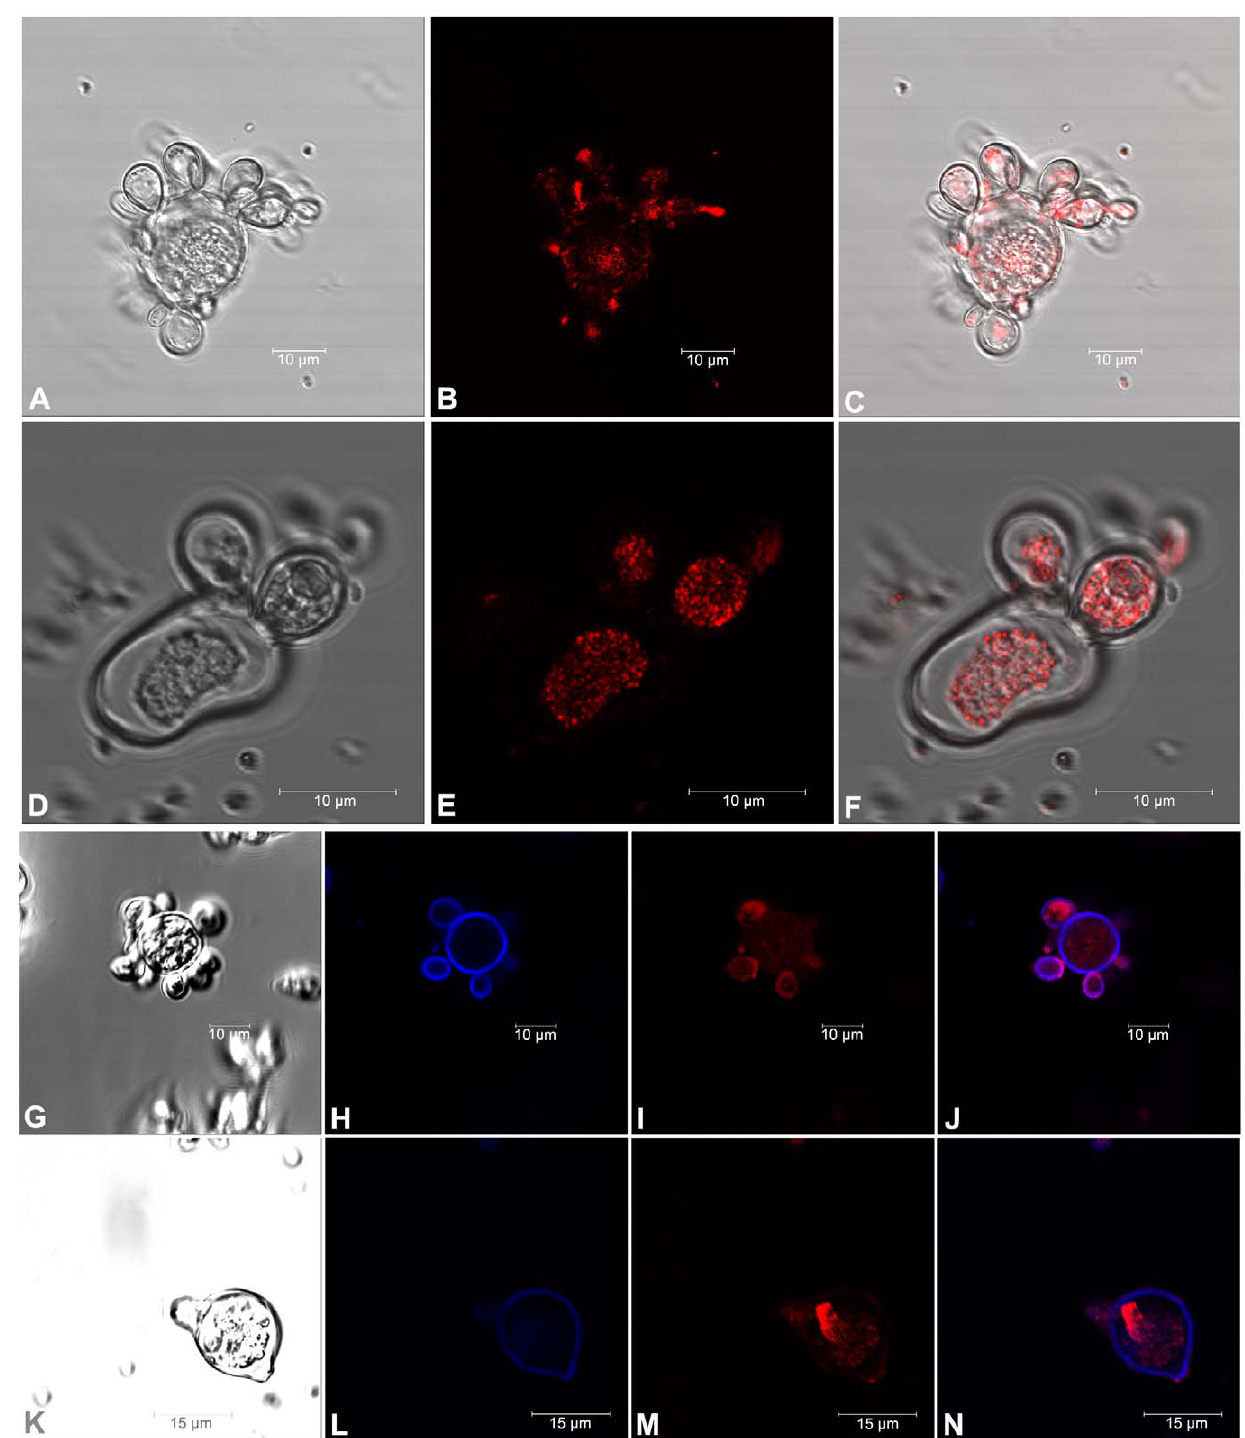
Figure 3. Effect of tunicamycin (TM) on the distribution of paracoccin in P.brasiliensis yeasts. Fluorescence labeling with anti-paracoccin IgY was evenly distributed over the yeast surface. In some budding regions, a more intense labeling was detected for untreated P. brasiliensis yeast cells (B, C, I and J) compared with those treated with TM (E, F, M and N), which were more centrally labeled. Panels H and L show fluorescence labeling chitin, while panels B, E, I and M show fluorescence labeling paracoccin. C is the merge of A and B; F is the merge of D and E; J is the merge of G, H and I; and N is the merge of K, L and M. doi:10.1371/journal.pone.0029216.g003 In addition, the kinetic parameters of the NAGase activity were non-linear-regression analysis of data obtained by measuring the determined for fully glycosylated and underglycosylated prepara- rate of r -nitrophenyl- b - N -acetylglucosaminide ( r NP-GlcNAc) hy- tions. The Michaelis–Menten constant (K m ) was determined from drolysis (0.01–0.1 mM). Table 1 shows that the K m of the NAGase